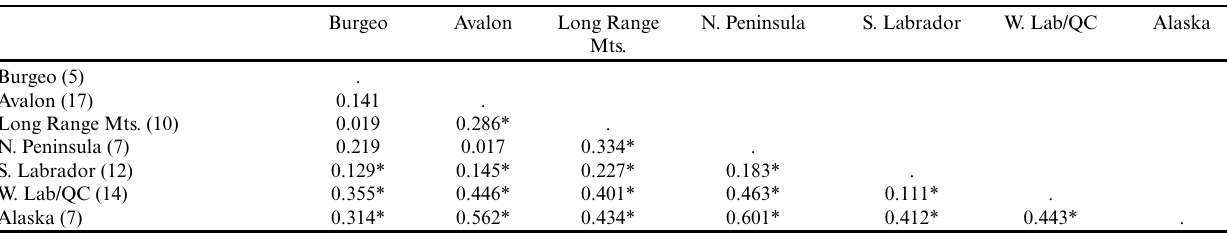
Table 1 . Pairwise φ st based on mitochondrial ND2 between all regional groupings of Gray-cheeked Thrushes ( Catharus minimus ). The number of samples in each group is indicated in parentheses. Significance was determined from 1000 permutations in Arlequin using the Kimura 2P mutation model. Refer to Appendix 1 and Figure 1 for the geographical location of each group and other sampling details. Note that the western Labrador / Quebec (i.e. W. Lab/QC) and Alaska groupings fall within the range of the putative C. m. aliciae subspecies while all other samples fall within the range of the putative C. m. minimus subspecies. Burgeo Avalon Long Range Mts.